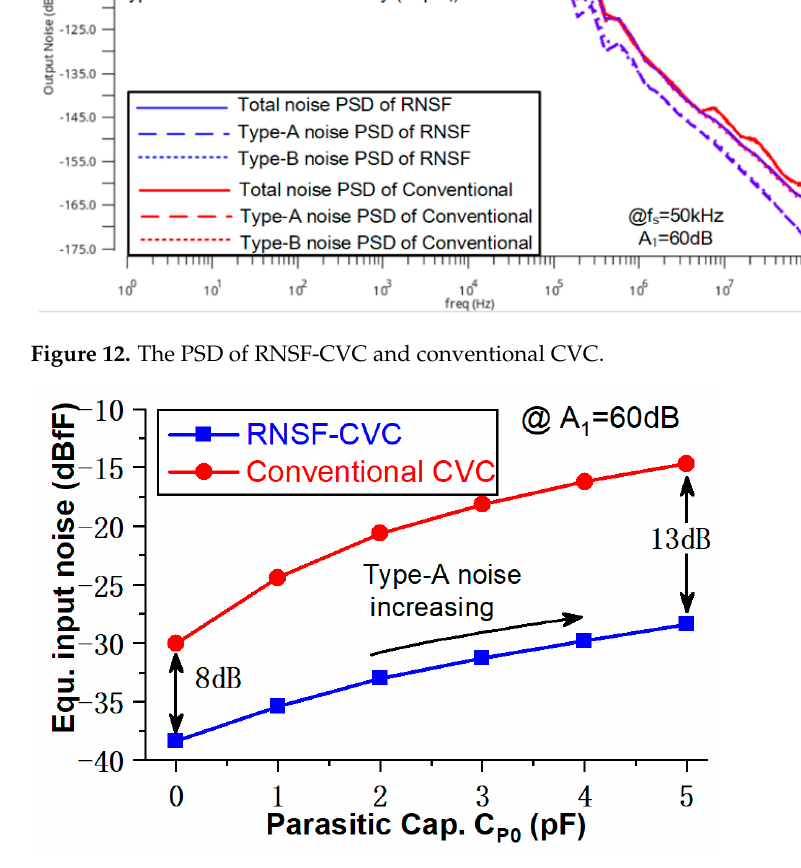
Figure 12. The PSD of RNSF-CVC and conventional CVC.